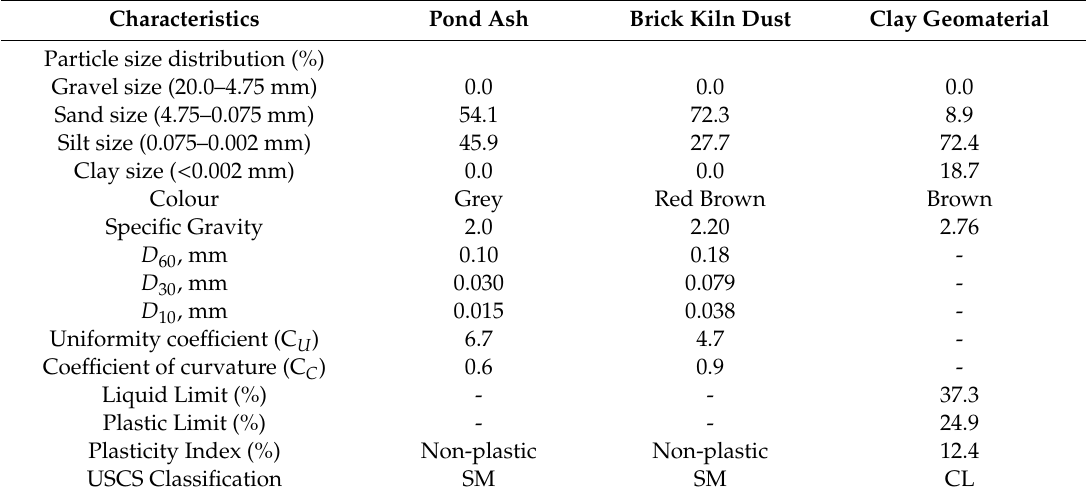
Table 1. Physical Characteristics of the raw